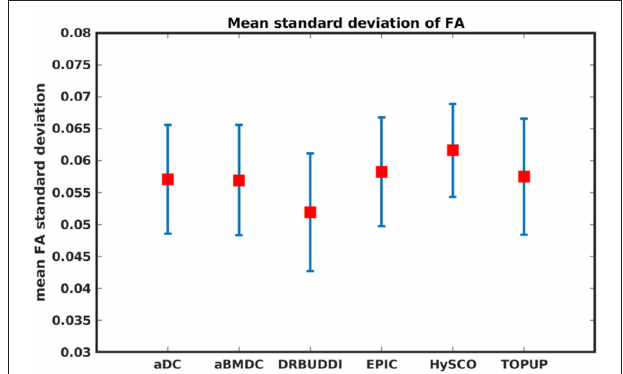
FIGURE 17 | Mean FA standard deviation over LR, RL, AP, and PA data for 40 dHCP subjects using the six methods. The error bars represent standard deviation of this metric across subjects. DR-BUDDI produces the smallest standard